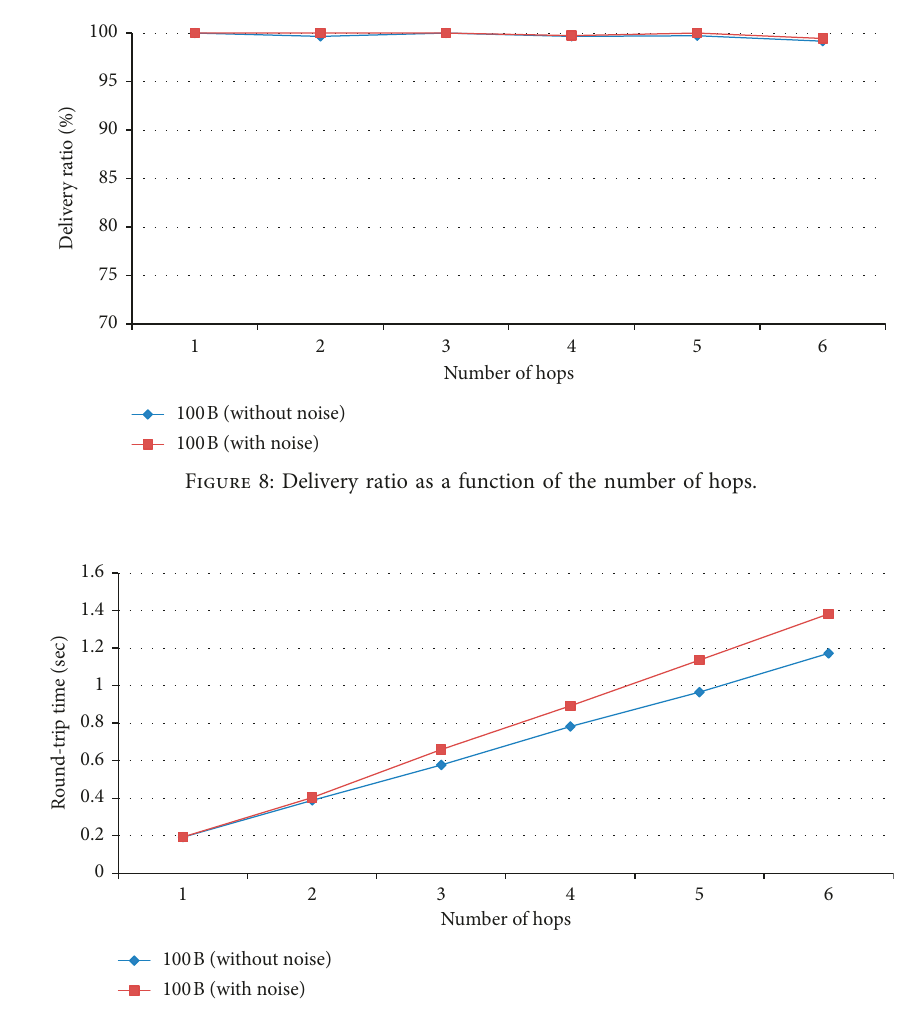
Figure 9: RTT as a function of the number of